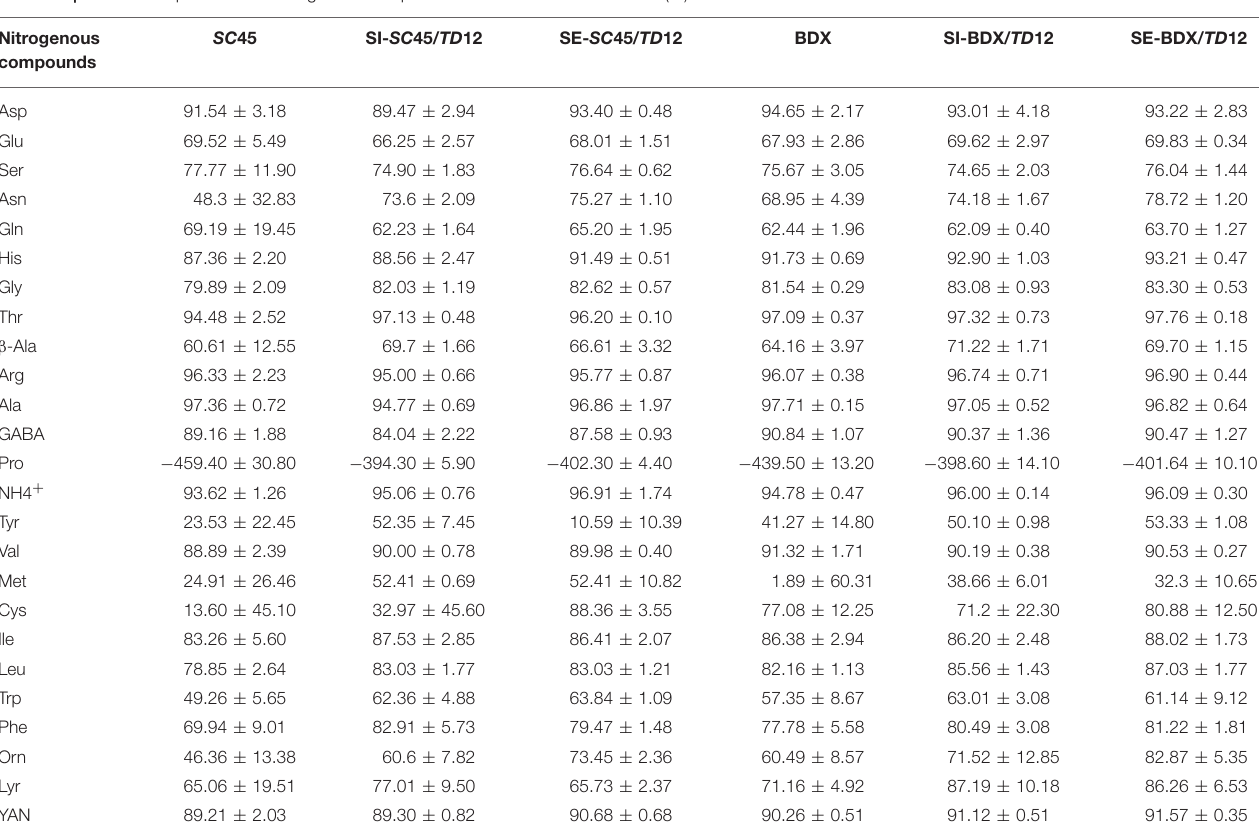
TABLE 2 | The consumption ratio of nitrogenous compounds after alcoholic fermentation(%). Nitrogenous